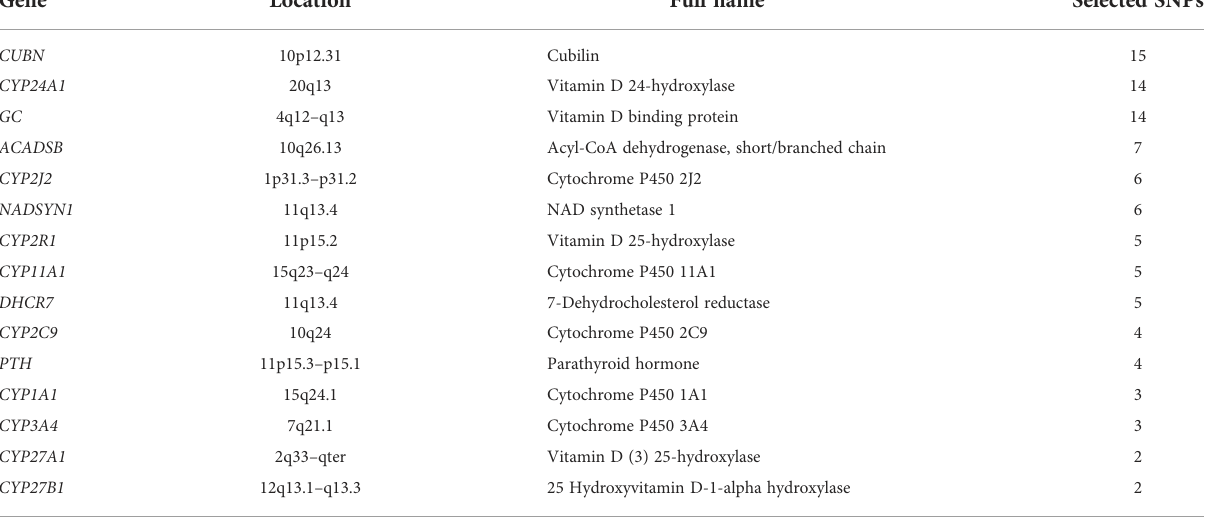
TABLE 1 The basic characteristics of the 15 candidate